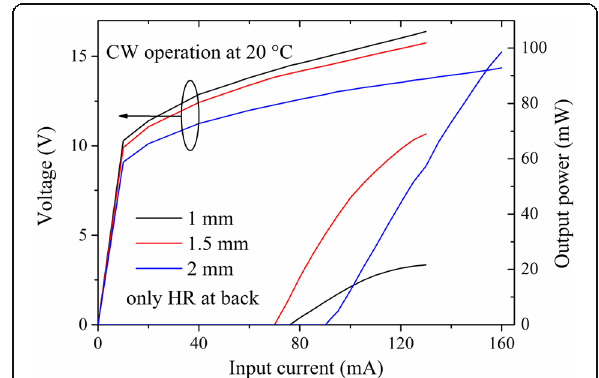
Fig. 2 Typical CW PIV characterization of the DFB QCLs with different cavity lengths of 1, 1.5, and 2 mm and ridge width of 9 μ m